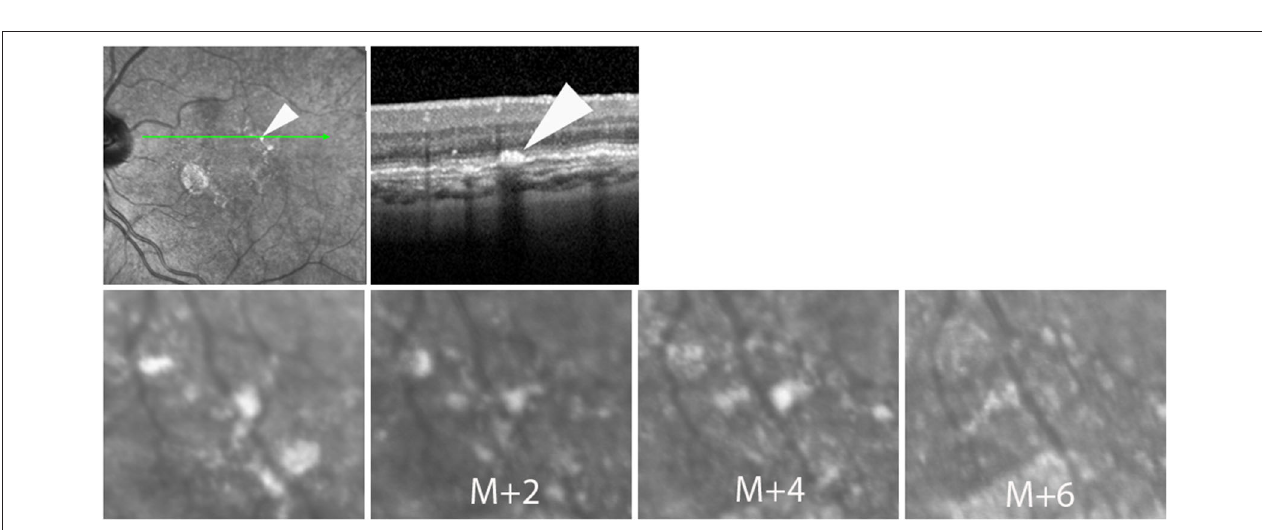
FIGURE 2 | Case 4. Successive SLO images illustrating the change in the shape of a hyperreflective spot during